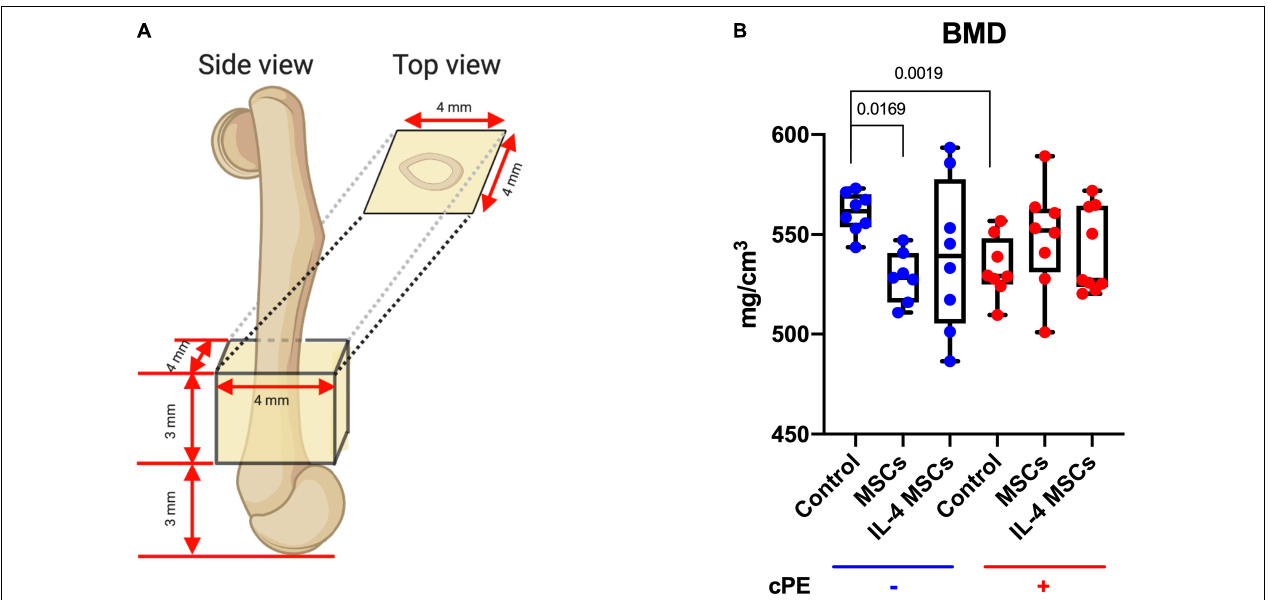
FIGURE 2 | Bone Mineral Density (BMD) within the ROI for all groups. (A) The 3D ROI was defined as a 4 mm × 4 mm × 3 mm box and started 3 mm from the distal femur end. (B) Quantitative assessments of BMD within the region of interest for all groups. (cPE- control group: n = 8; cPE- MSCs group: n = 7; cPE- IL-4 MSCs group: n = 8; cPE + control group: n = 8; cPE + MSCs group: n = 8; cPE + IL-4 MSCs group: n = 9).